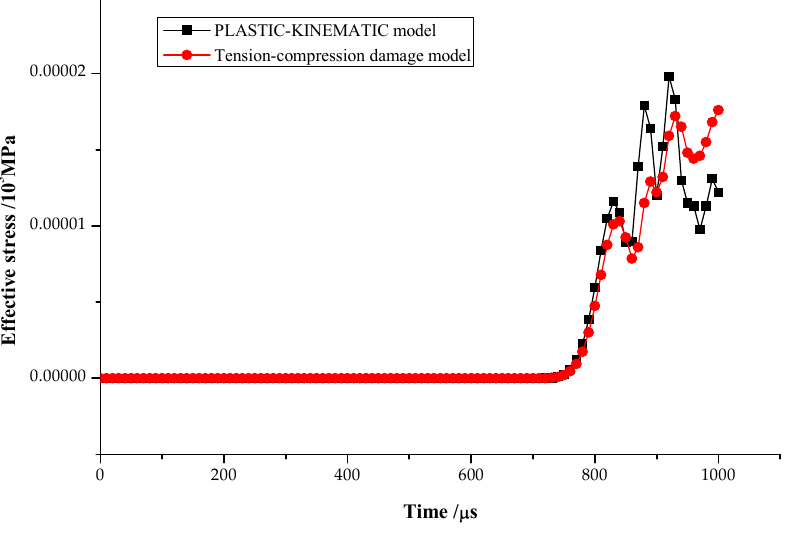
Figure 4. Effective stress-time curves for monitoring point 2.